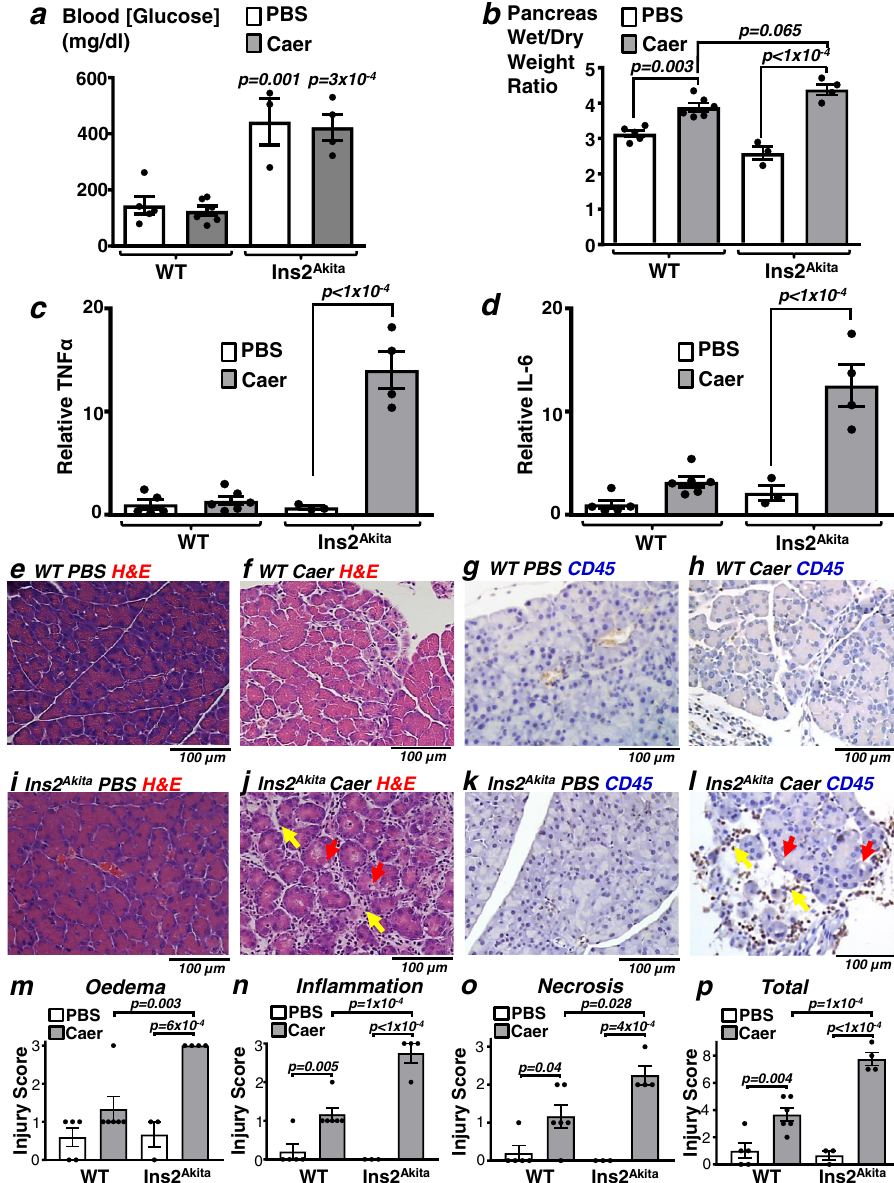
Fig. 1 Caerulein-induced pancreatitis is more severe in type-1 diabetic Ins2 Akita mice vs wild type (WT) control mice. Pancreatitis was induced in WT and type-1 diabetic Ins2 Akita mice by caerulein (Caer; 50 µ g/Kg × 8 hourly IP injections over 2 days) or phosphate-buffered saline (PBS) as a control and blood/tissue was harvested 24 h after the last injection. Blood glucose ( a ) and multiple readouts of pancreatitis were assessed ( b – p ). These include; pancreatic tissue oedema (wet/dry weight ratio, b ), cytokine expression (qPCR of tissue mRNA; TNF α , c ; IL-6, d ), histological signs of injury (haematoxylin and eosin (H&E), e , f , i and j ), immunohistochemistry of the in fl ammatory marker, CD45 (brown) ( g , h , k and l ). Yellow and red arrows in j and l indicate vacuole formation and in fl ammatory cell in fi ltration, respectively. m – p Histology injury scores (where 3 is the most severe) for oedema ( m ), in fl ammatory cell in fi ltration ( n ), necrosis ( o ), and total score ( p ; sum of other scores). Group sizes were: WT PBS, n = 5; WT Caer, n = 6; Ins2 Akita PBS, n = 3; Ins2 Akita Caer, n = 4. Signi fi cance (exact p values as indicated) was determined by one-way ANOVA with Sidak ’ s multiple comparisons. Data are presented as mean value ±